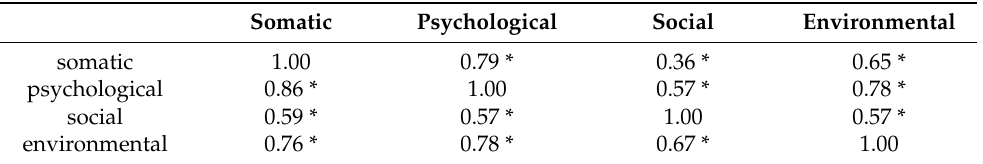
Table 7. Spearman’s correlation matrix of domain scores for the inactive women (upper triangle) and for the active women (lower triangle).